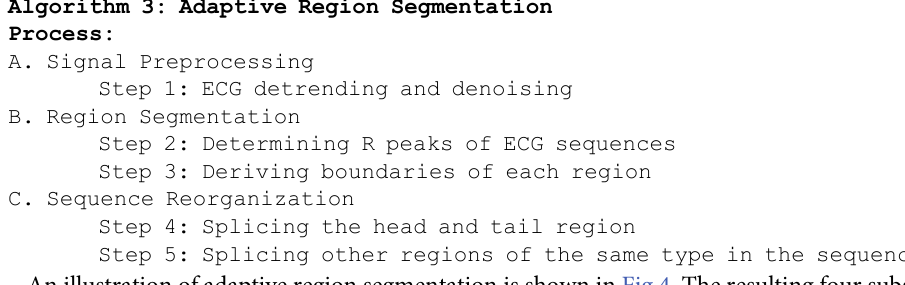
Algorithm 3: Adaptive Region